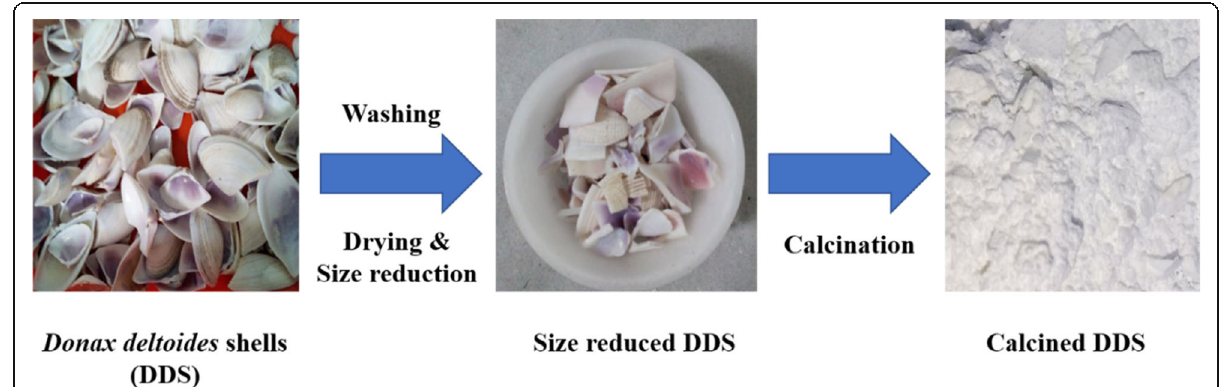
Fig. 1 Schematic flow of catalyst